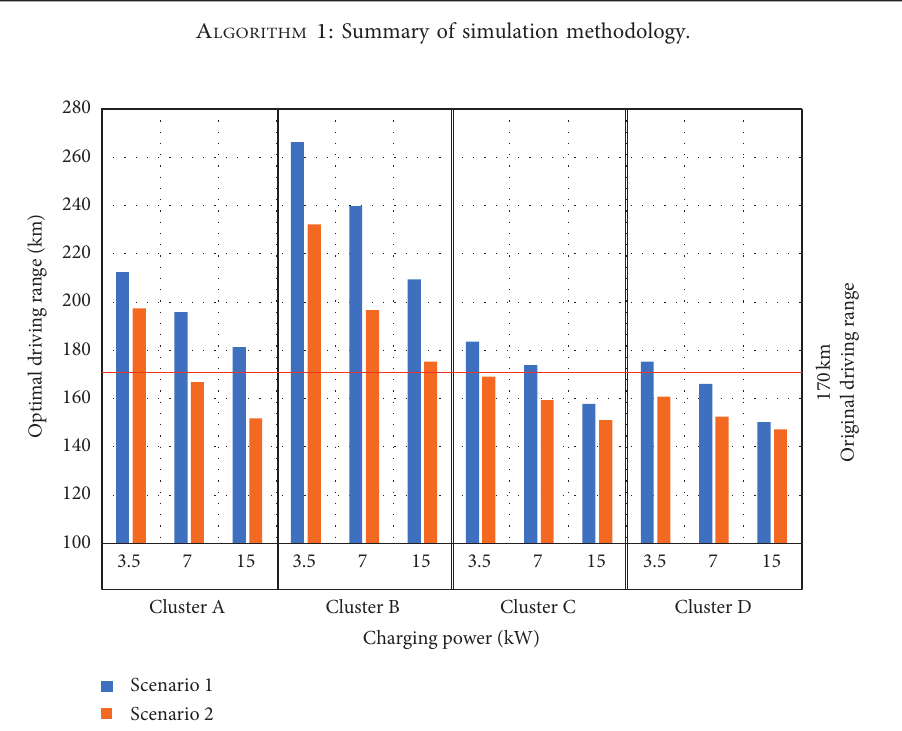
Figure 6: Optimal driving range for two scenarios when θ �